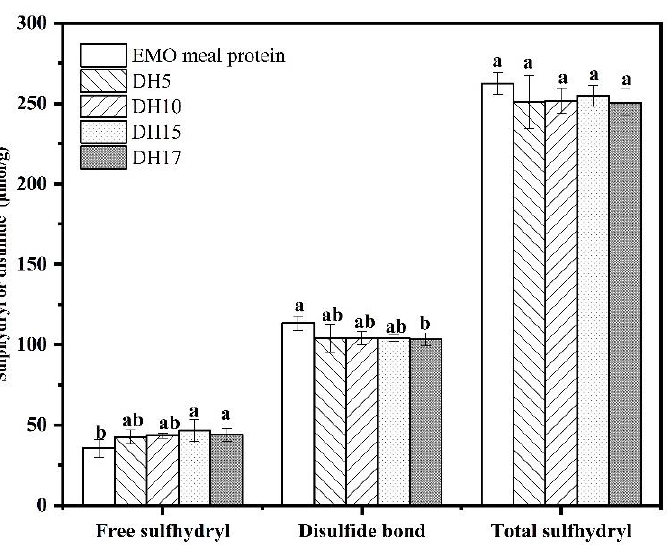
Figure 2. Changes in disulfide bond contents, free sulfhydryl, and total sulfhydryl of EMO meal protein and hydrolysates with different DH. The value of different superscript letters indicated significant difference ( p < 0.05).